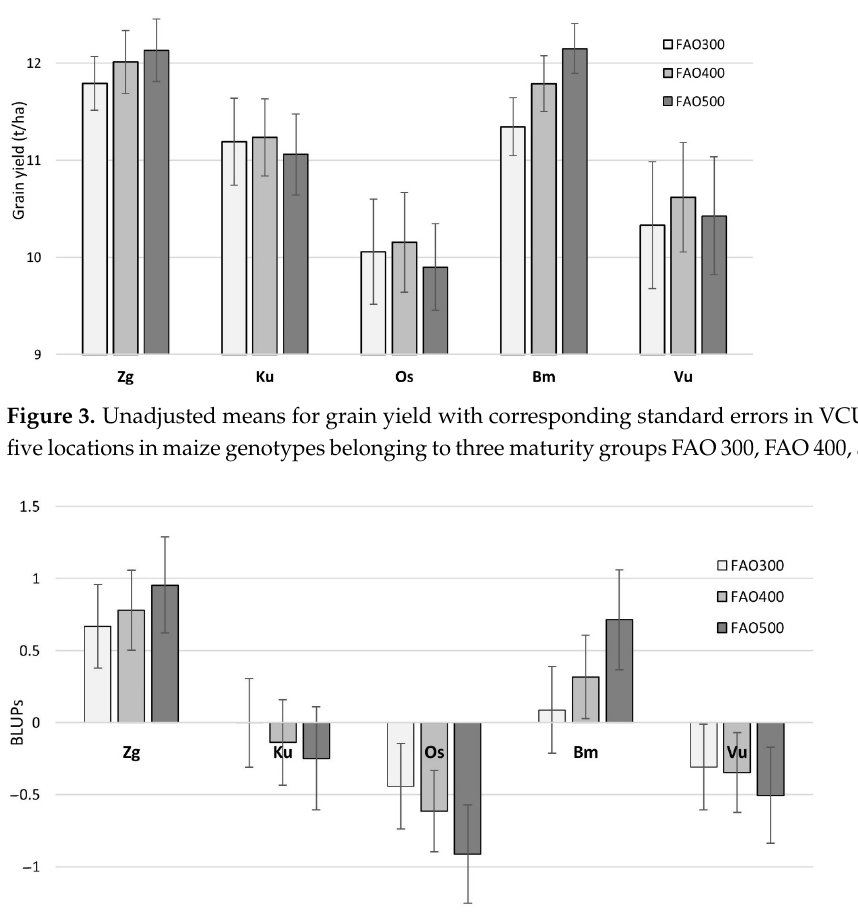
Figure 4. The best linear unbiased predictions of random Location effects (L_BLUPs) with corresponding standard errors in VCU trials in maize genotypes belonging to three maturity groups FAO 300, FAO 400, and FAO 500.